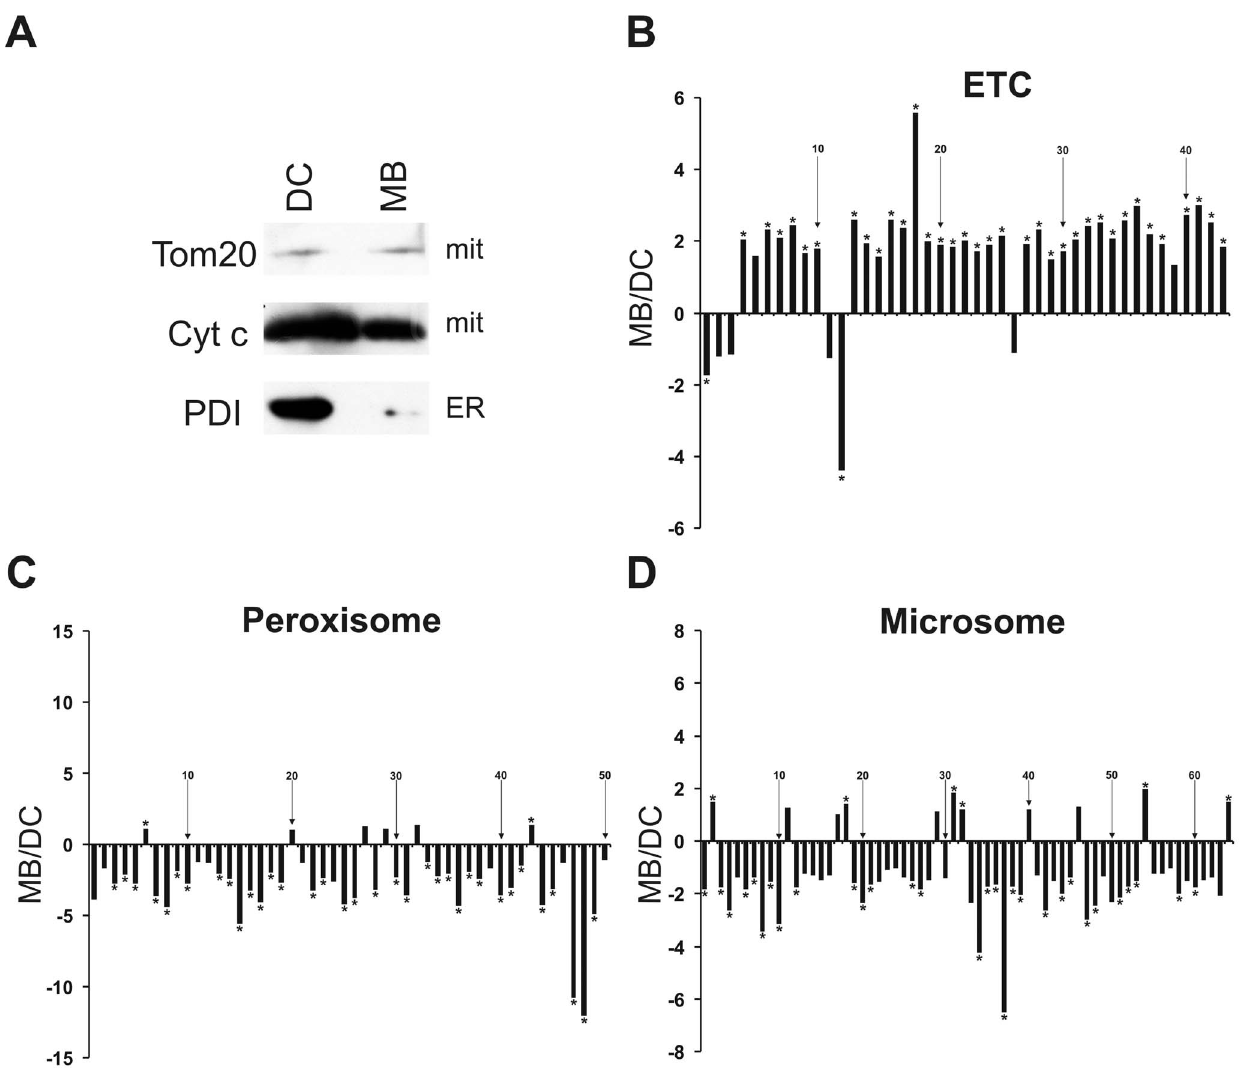
Figure 4. Liver mitochondria isolated by magnetic beads show less non-mitochondrial proteins than mitochondria isolated by differential centrifugation. A Mitochondrial preparation obtained by differential centrifugation (DC) was compared to anti-TOM22 magnetic beads (MB) isolation by Western blot using antibodies against mitochondrial (TOM20 and cytochrome c) and ER (PDI) marker proteins. B–D Proteins were identified by mass spectrometry and averages of eight samples per group were calculated for MB and DC mitochondrial fractions, respectively. The relative abundance is represented as a linear ratio (average of MB/average of DC). When these ratios were less than 1 (DC average . MB average) the negative inverse ratio was taken and the values were transposed by the equation: 2 1/(MB/DC ratio). Positive ratios indicate the presence of higher protein levels in the MB fraction, whereas negative ratios indicate higher protein levels in the DC fraction. Diagram titles indicate the applied GO terms, which were identified by Genomatix software GO term analysis. Statistical analyzes were made by Mann-Whitney U test and p values were corrected to multiple testing according to Benjamini&Hochberg [23]. A false discovery rate (FDR) , 10% was set as the significance level and significant proteins are denoted by stars. Numbers are given for every tenth protein and the names of the identified proteins are summarized in Table S1. ETC: electron transport chain. doi:10.1371/journal.pone.0082392.g004 operator. In addition, this method is suitable for the automated homogenization of multiple samples simultaneously. We tested the homogenization steps for different tissues and the integrity of the mitochondrial membranes was assessed by transmission EM analysis, oxygen consumption measurements and determination revealed homogenous mitochondrial fractions with a good beads from different mouse tissues. Our Western blot and Clark